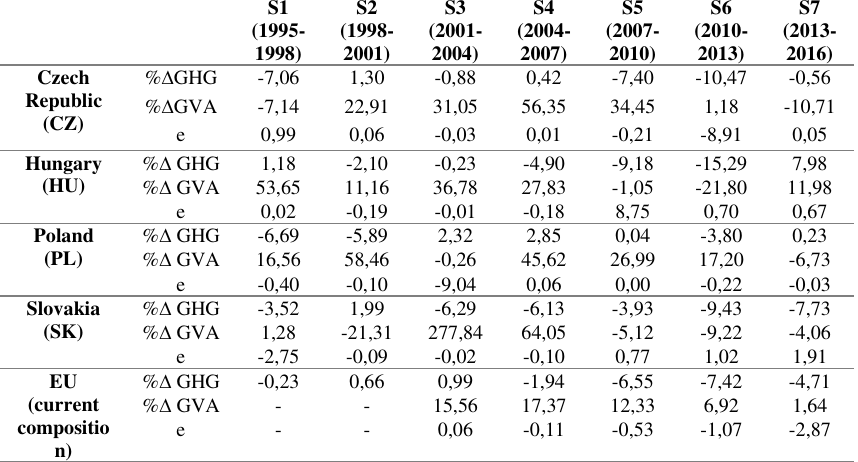
Table 1. The values of decoupling elasticity of the V4 countries